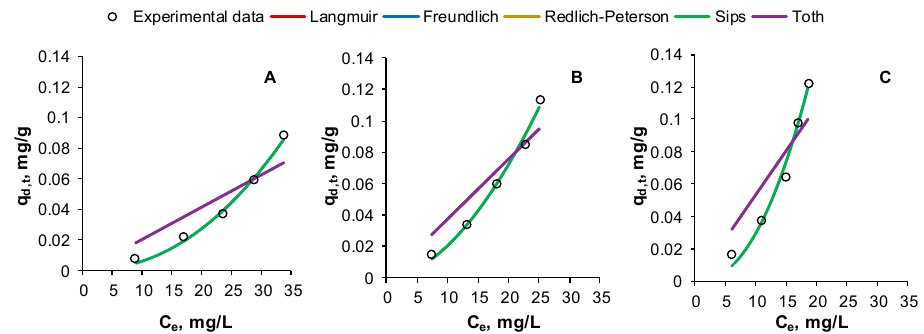
Figure 10. Equilibrium isotherms for Reactive Black 5 dye desorption from the prepared adsorbent in first cycle ( A ), second cycle ( B ) and third cycle ( C ) (RB volume: 30 mL, RB initial concentration: 30 mg/L, eluent volume: 30 mL, eluent concentration: 1 M, adsorbent amount: 3 g, contact time: 6 h, temperature: 40 °C). Table 4. Equilibrium isotherm parameters and statistical functions of RB desorption from CSCH.